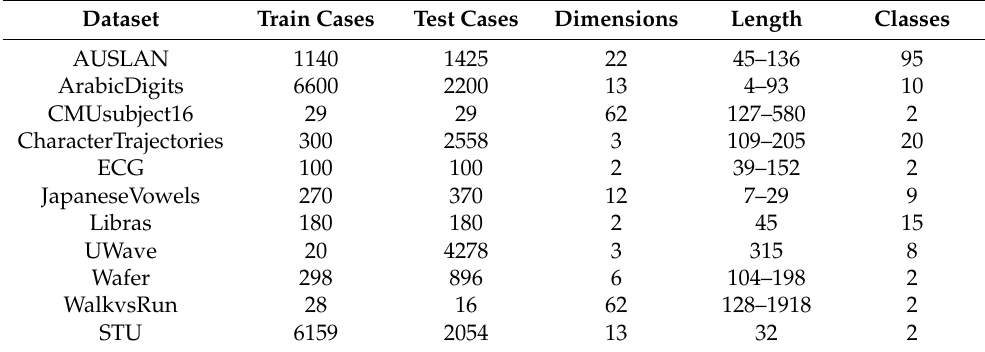
Table 1. The multivariate time-series classification